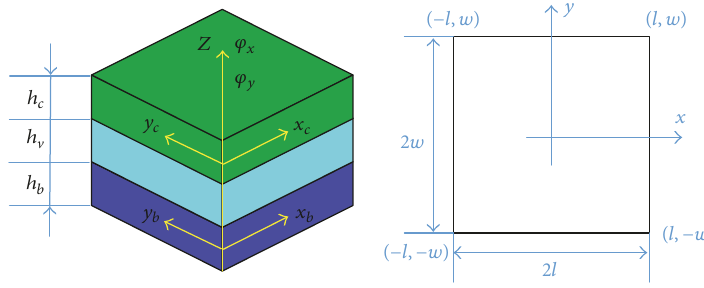
Figure 2: Composite element for